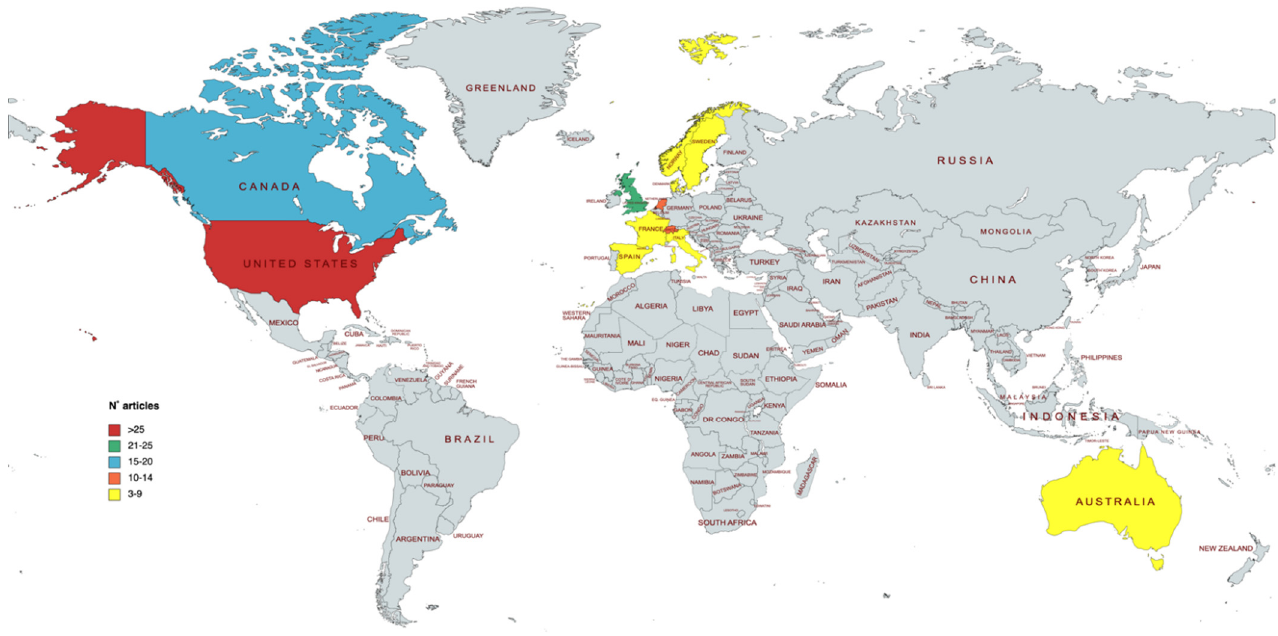
Figure 6. The distribution map of the number of published articles worldwide for countries (Map-Chart).